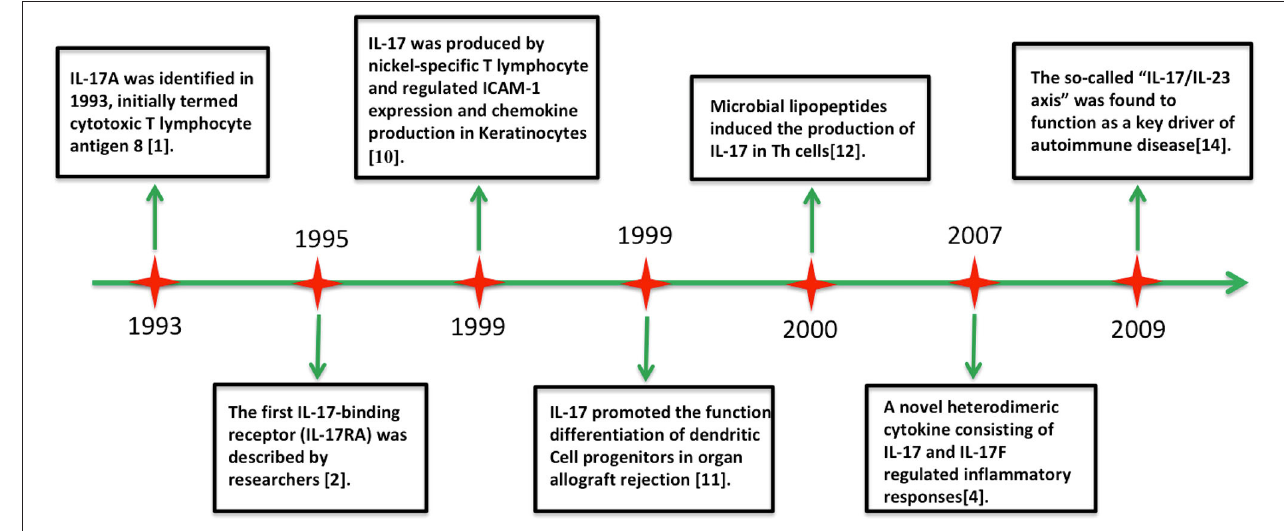
FIGURE 1 | Timeline of advances in the research on interleukin-17